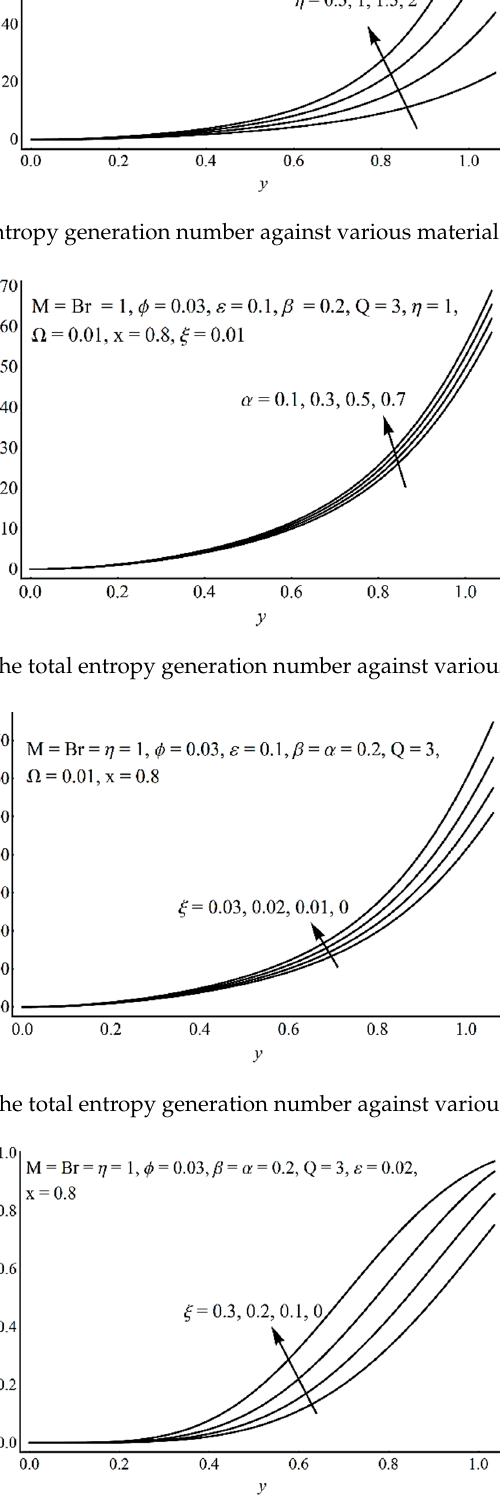
Figure 22. The Bejan number against various ξ values.